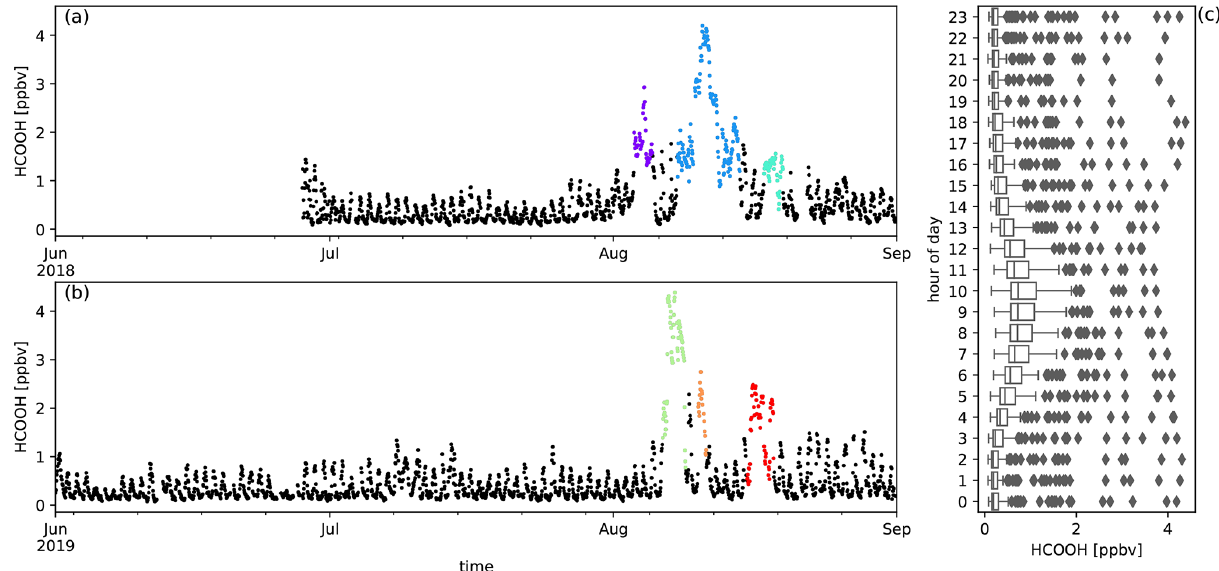
Figure A4. Measured HCOOH mixing ratios (ppbv) during austral winter 2018 (a) and austral winter 2019 (b) together with the diel distribution of hourly averages (c) . Biomass burning plumes under investigation are highlighted in colours.